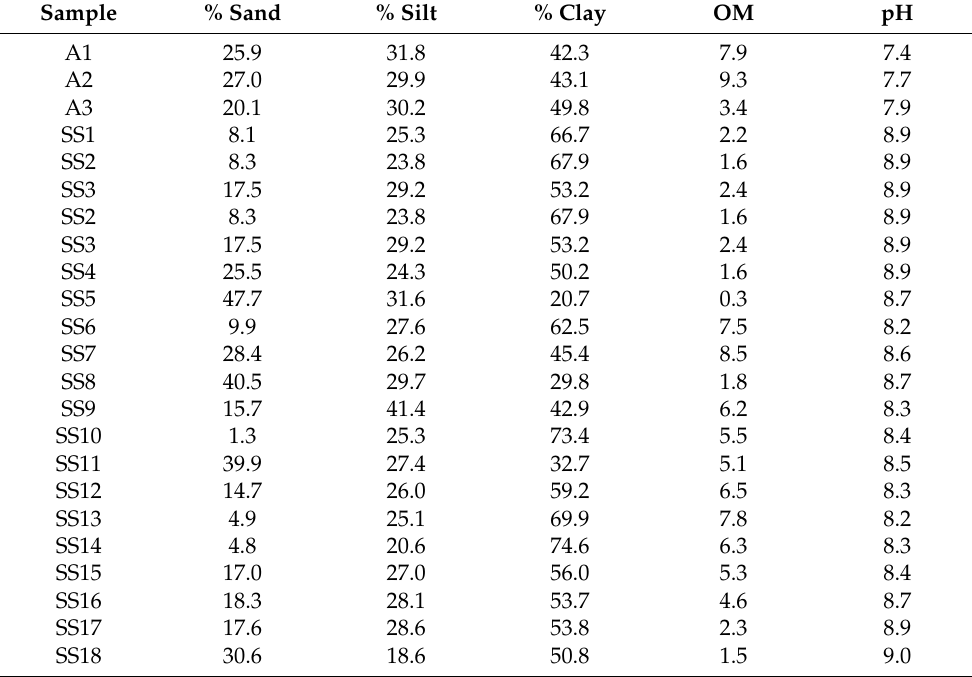
Table 2. Granulometric characteristics and physicochemical properties, organic matter (OM), and pH value in studied